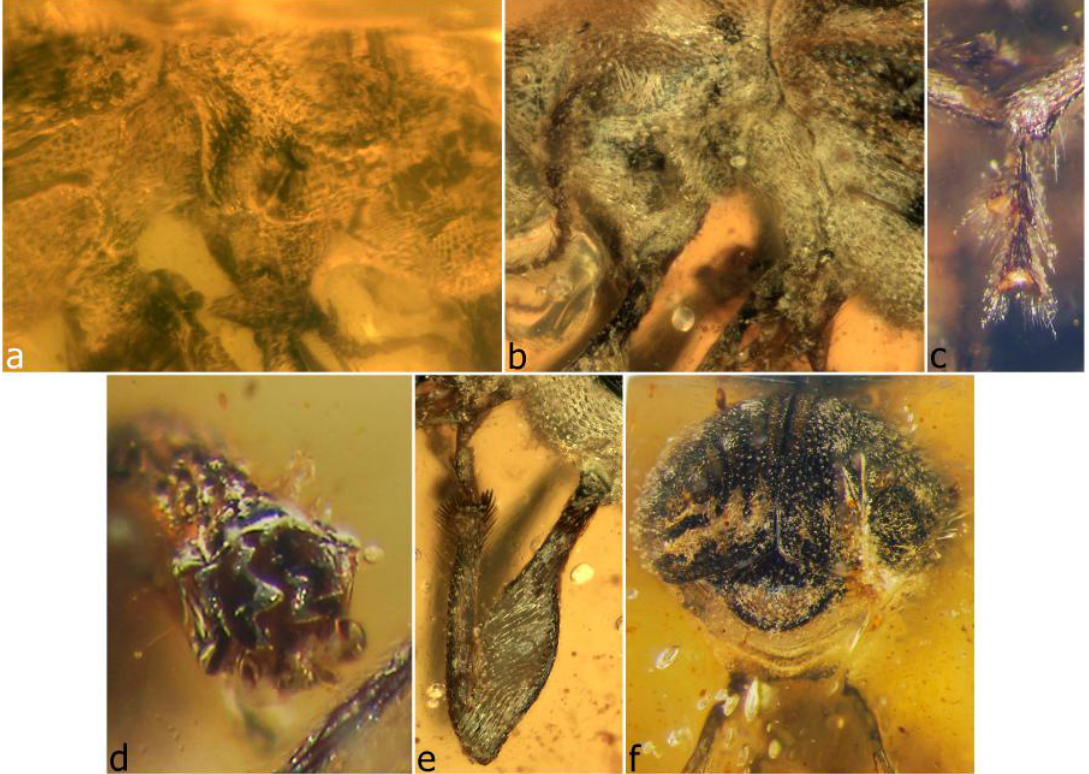
Figure 66. Compsopsarus reneae sp. n., holotype. Thorax, right lateral ( a ); thorax, left lateral ( b ); tarsites 1 and 2 ( c ); mandibles, apical ( d ); left hind leg ( e ); abdomen, showing pygidium, caudal.